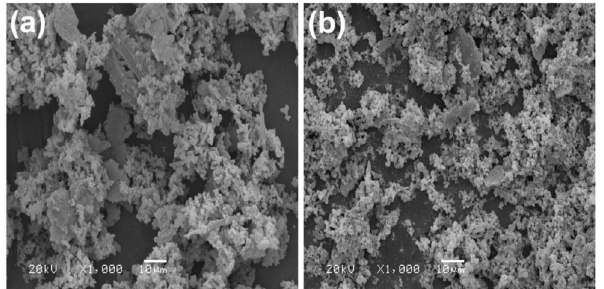
Fig. 7 SEM morphologies of wear debris after tribocorrosion in seawater with (a) 0 M and (b) 1.0 M halide concentrations,